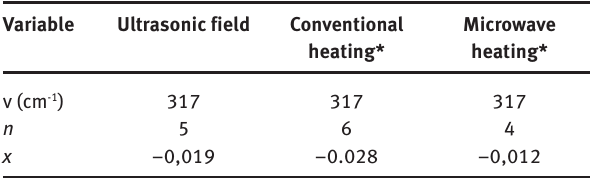
Table 3: The values of ν, n and x for caffeine extraction under influ- ence of US, CH, and